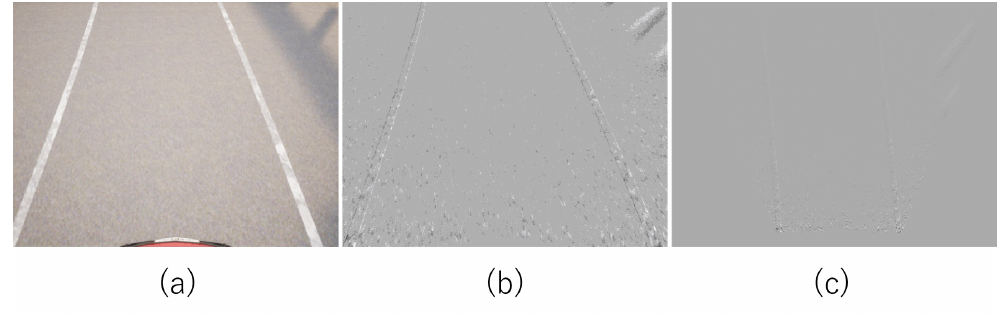
Figure 4. Road images taken at an angle as created by CARLA. ( a ) RGB image (not used). ( b ) Accumulated events. ( c ) Bird’s-eye view transformation of